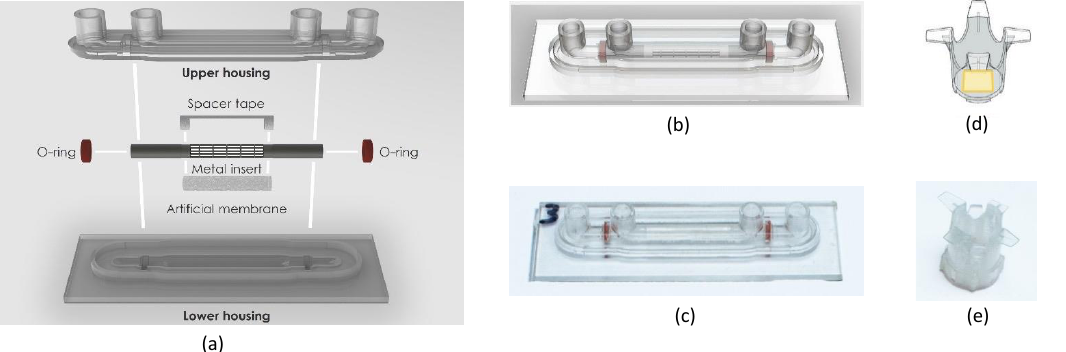
Figure 2. Demonstrations of the flexibility of prototyping devices with unconventional geometries by 3D-printing using a Polyjet printer, including ( a ) an exploded view of a 3D, vascular capillary-shaped BBB model based on Polyjet-printed rigid upper and lower housings to form two fluidic channels, containing a 1-mm diameter hollow cylinder which was micromachined as a scaffolding structure for the membrane layer, which is affixed to the scaffold with spacer tape. Mechanically punched silicone o-rings were used to seal the inner and outer channels from each other; ( b ) a render of the device, and ( c ) a photograph of the final prototyped device; ( d ) a CAD model of a novel transwell insert based on a dimensions of an insert for a standard 24-well transfer plate, where the yellow section is a removable 2 × 2 mm membrane with a 3D-printed frame, which was inserted into a 3D-printed flanged carrier; ( e ) a photograph of the prototyped novel 24-well transwell plate insert with removable membrane.